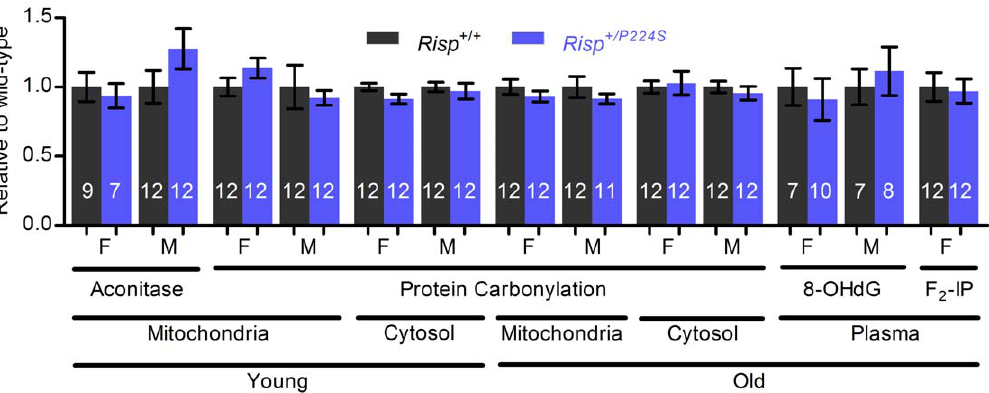
Figure 5. Biomarkers of oxidative stress are not affected by Risp heterozygosity. Various biomarkers of oxidative stress (enzymatic activity of aconitase, protein carbonylation, 8-OHdG and F 2 -isoprostanes) were measured in mitochondria, cytosol or plasma of young or old mice, as indicated. The sex of the mice is indicated below each bar (F for female, M for male). Values were normalized to a wild-type value of 1. Sample sizes are shown superimposed on each bar. Actual (not normalized) values are shown in Table